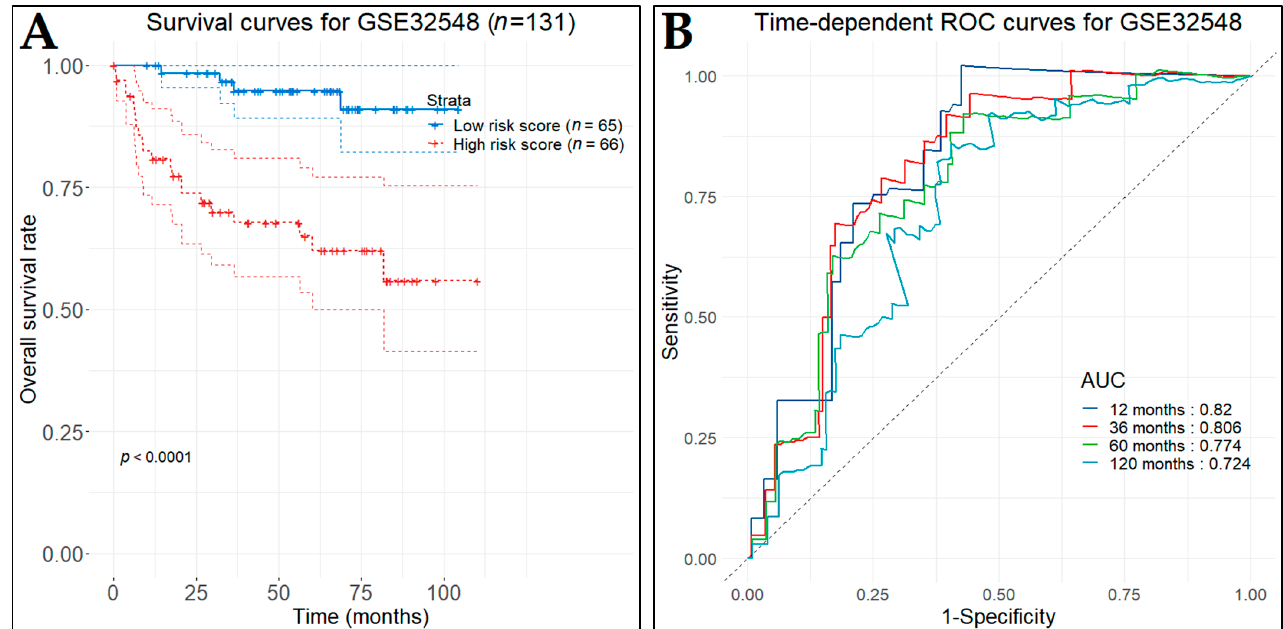
Figure 16. Survival analysis for the GSE32548 ( n = 131) dataset (second test set). ( A ) Kaplan–Meier curves for overall survival of BCa patients as stratified by the three-gene prognostic index. Patients were divided into low- and high-risk groups according to the median prognostic index. ( B ) Time- dependent ROC curves (one-, three-, five-, and ten-year predictions) to assess the prognostic accuracy of the three-gene prognostic model.